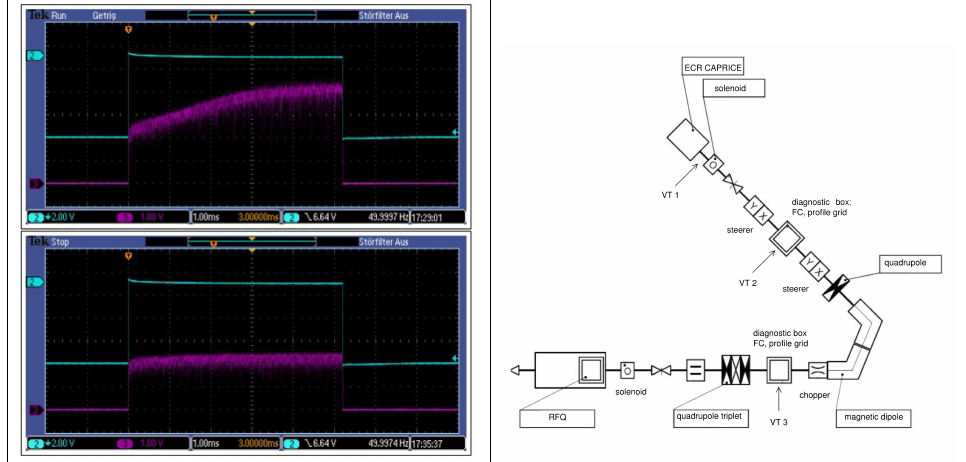
Figure 10. ( Left ): Pulse shape of a chopped ion beam, measured with a Faraday cup (FC) (violet) and timing signal for the chopper (blue). ( Top ): grid removed from the beam, ( Bottom ): profile grid inside the beam path. ( Right ): layout of beamline, showing the location of the chopper followed by the diagnostic box containing FC and profile grid. The location of each viewing target (VT 1–3) is shown also in experiments performed at GSI Darmstadt,